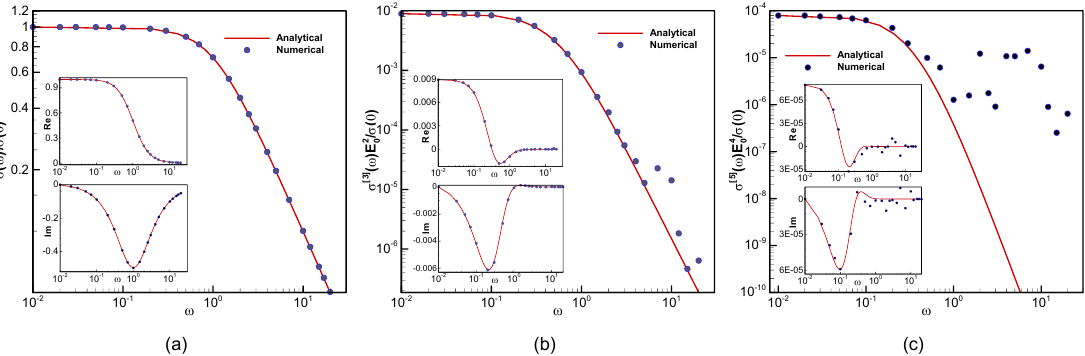
Figure 2. Validation of numerical solver: comparison between numerical and analytical results for calculated ( a ) first-order, ( b ) third-order, and ( c ) fifth-order conductivity at E 0 = 2 × 10 3 V/cm, τ = 1.0, β = 50, and µ = − 0.8.